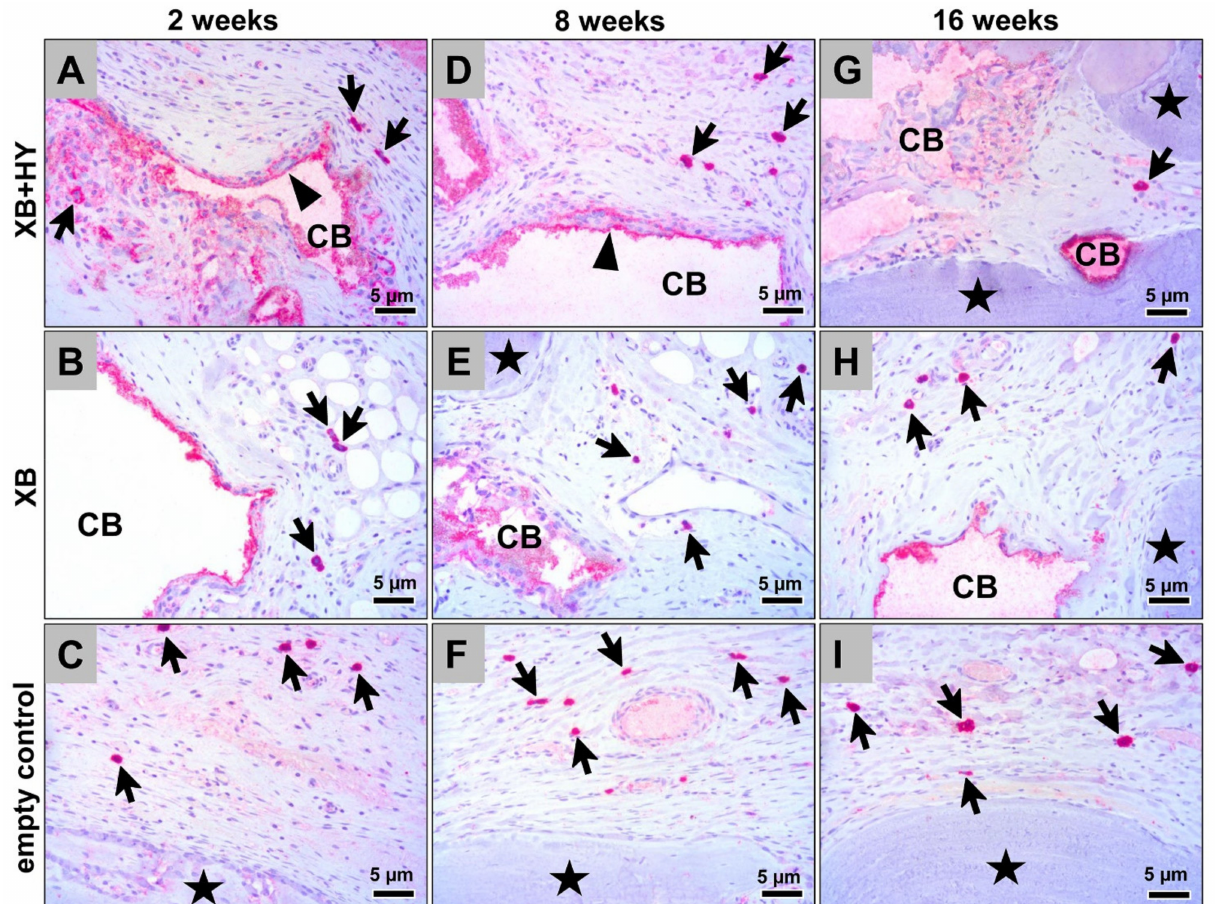
Figure 4. Representative histological images of the pro-inflammatory tissue response within the subcutaneous con- nective tissue of the different study groups based on immunohistochemical detection of the CD11c expression at 2 weeks ( A–C ), 8 weeks ( D–F ), and 16 weeks ( G–I ) post implantationem. Black arrows = M1-macrophages, black arrowheads = CD11c-positive multinucleated giant cells, black asterisk = newly formed bone, CB = granules of the xeno- geneic BSM, CT = connective tissue, (CD11c-immunostainings, 400 × magnification, scalebars = 5 µ